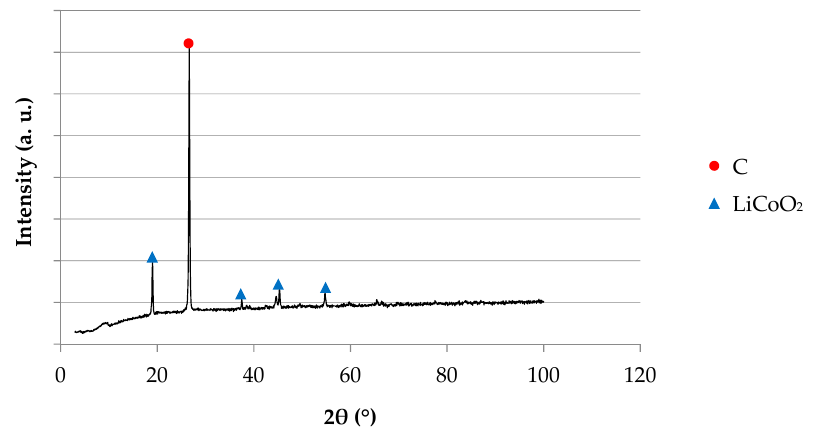
Figure 1. X-ray diffraction (XRD) analysis results for the battery mass formed after the mechanical processing of spent Li-ion batteries.